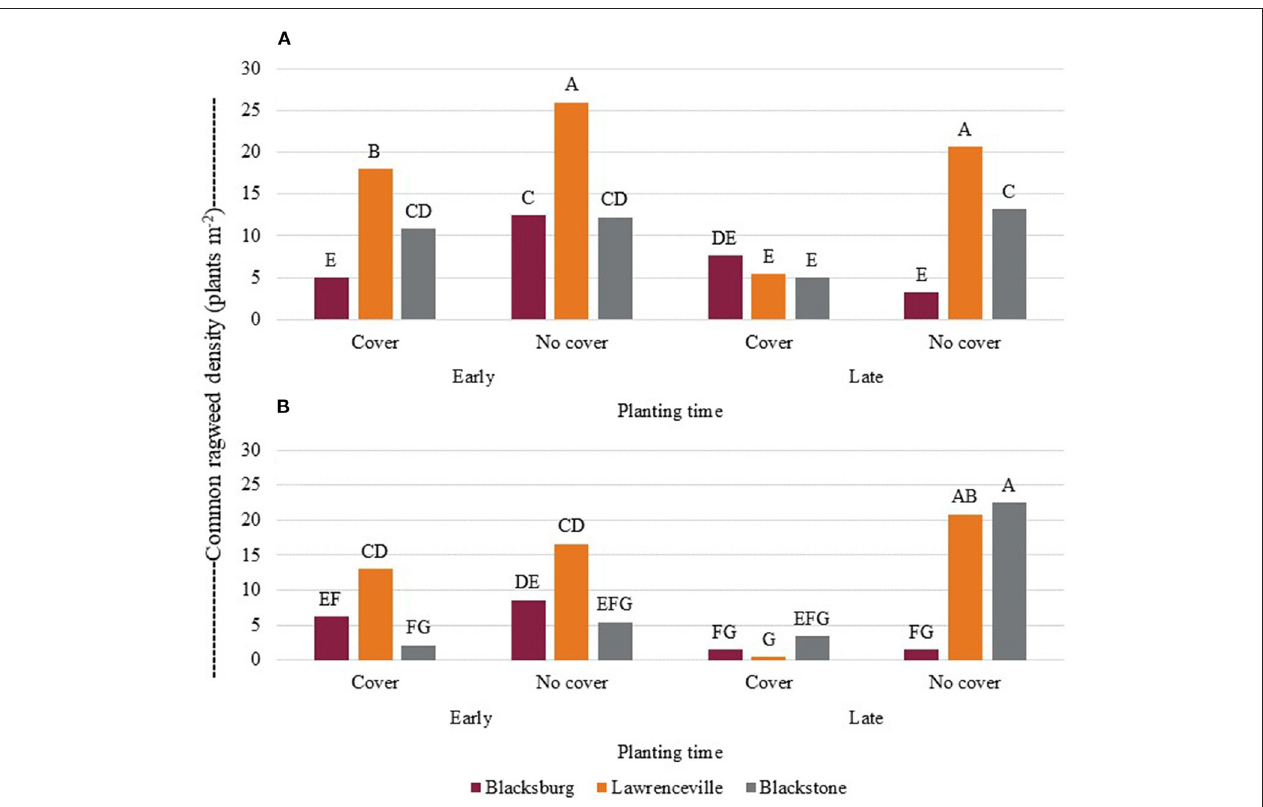
FIGURE 1 | Common ragweed density (A) at POST herbicide application (6 wk after planting) and (B) at soybean harvest by location, planting time, and ± winter cover in the first year of the field experiment. Means are considered statistically different when they do not share a letter according to Fisher’s Protected LSD ( P = 0.05) .